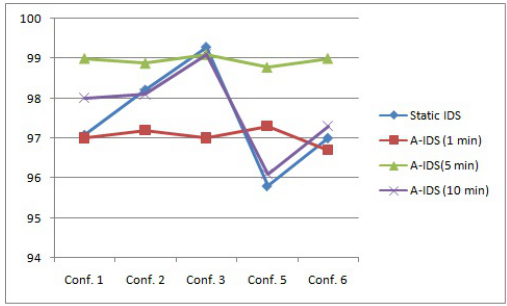
Figure 9. Time Gap affects the performance of the A-IDS